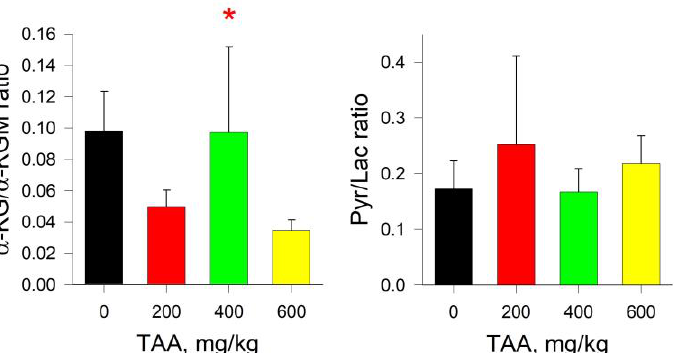
Figure 2. α - KG/α -KGM and Pyr/Lac ratios for blood plasma control and TAA-treated rats. p -values by Tukey ’s test: * — p < 0.1; red stars mean a pairwise comparison to TAA600 (for details see Table and Figures in Supplement S1).